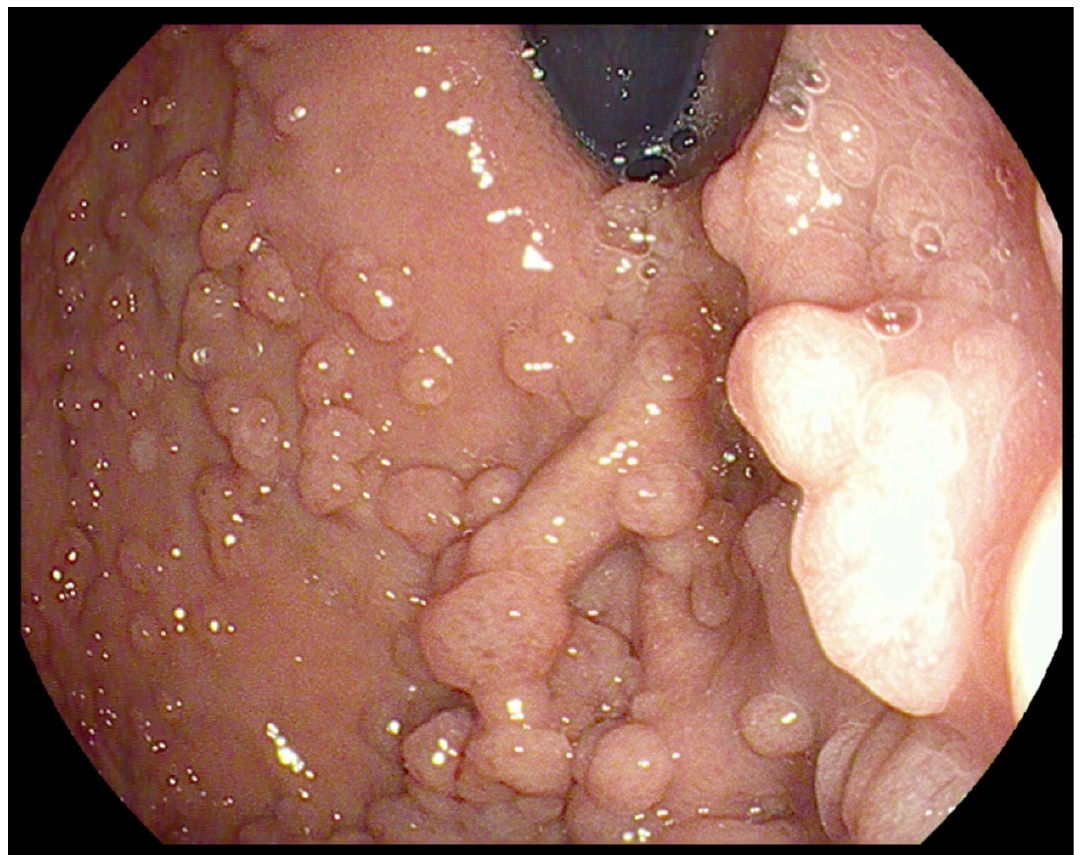
Figure 1. Fundic gland polyps visualized during endoscopy.